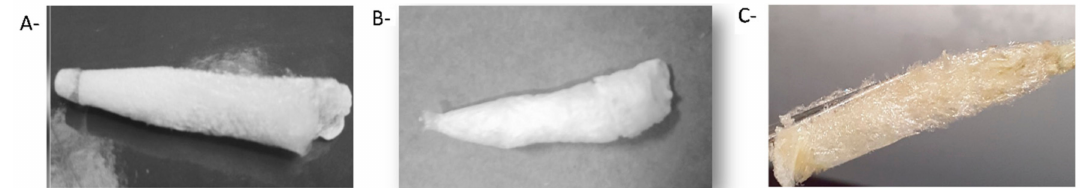
Figure 2. Lyophilized i -carrageenan: ( A ) native polysaccharide (free-catalyst support); ( B ) PdCl 2 (TPP) 2 supported on polysaccharides; ( C ) PdCl 2 (TPPTS) 2 supported on polysaccharides.